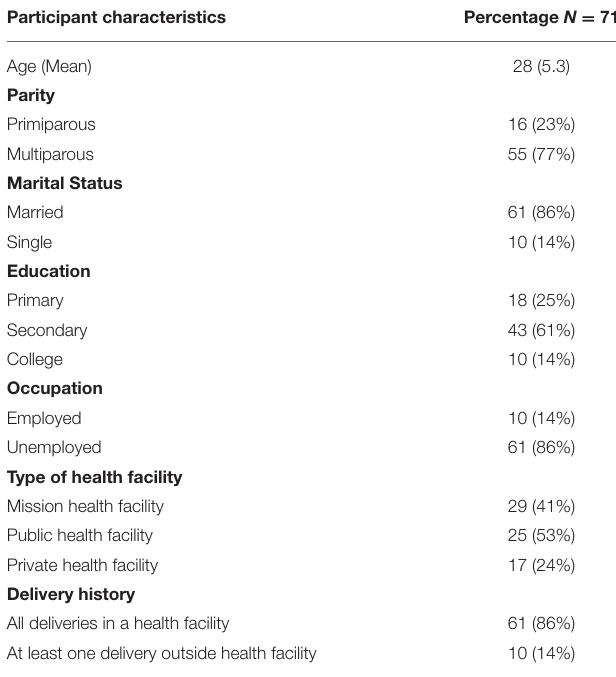
TABLE 1 | Sociodemographic characteristics of the